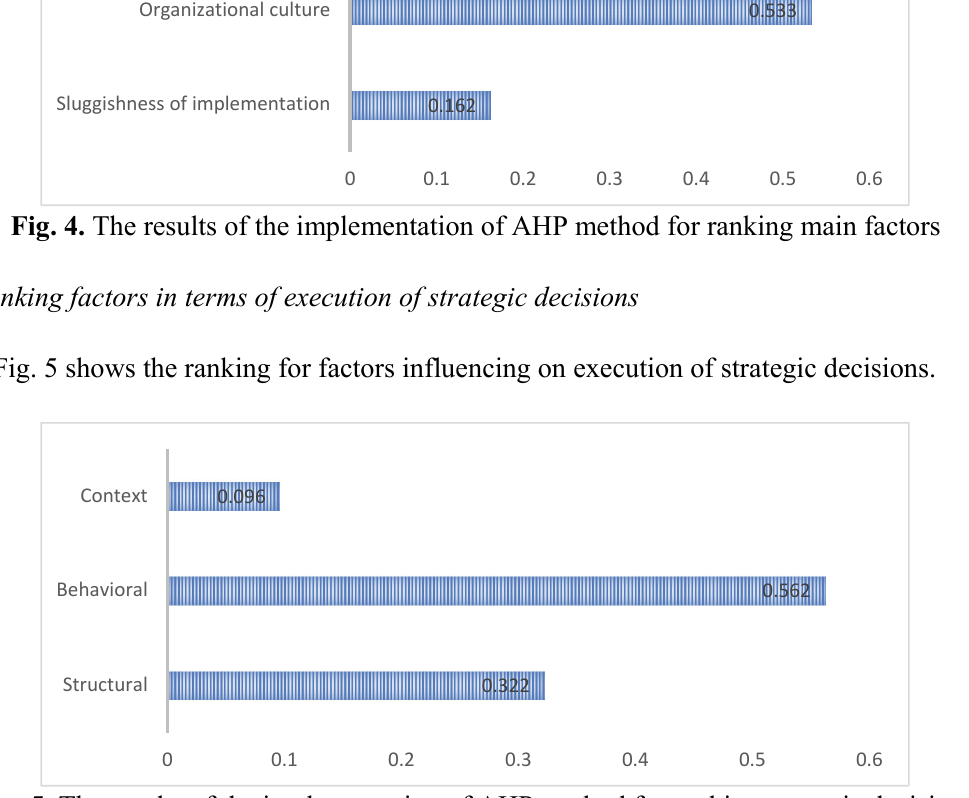
Fig. 5. The results of the implementation of AHP method for ranking strategic